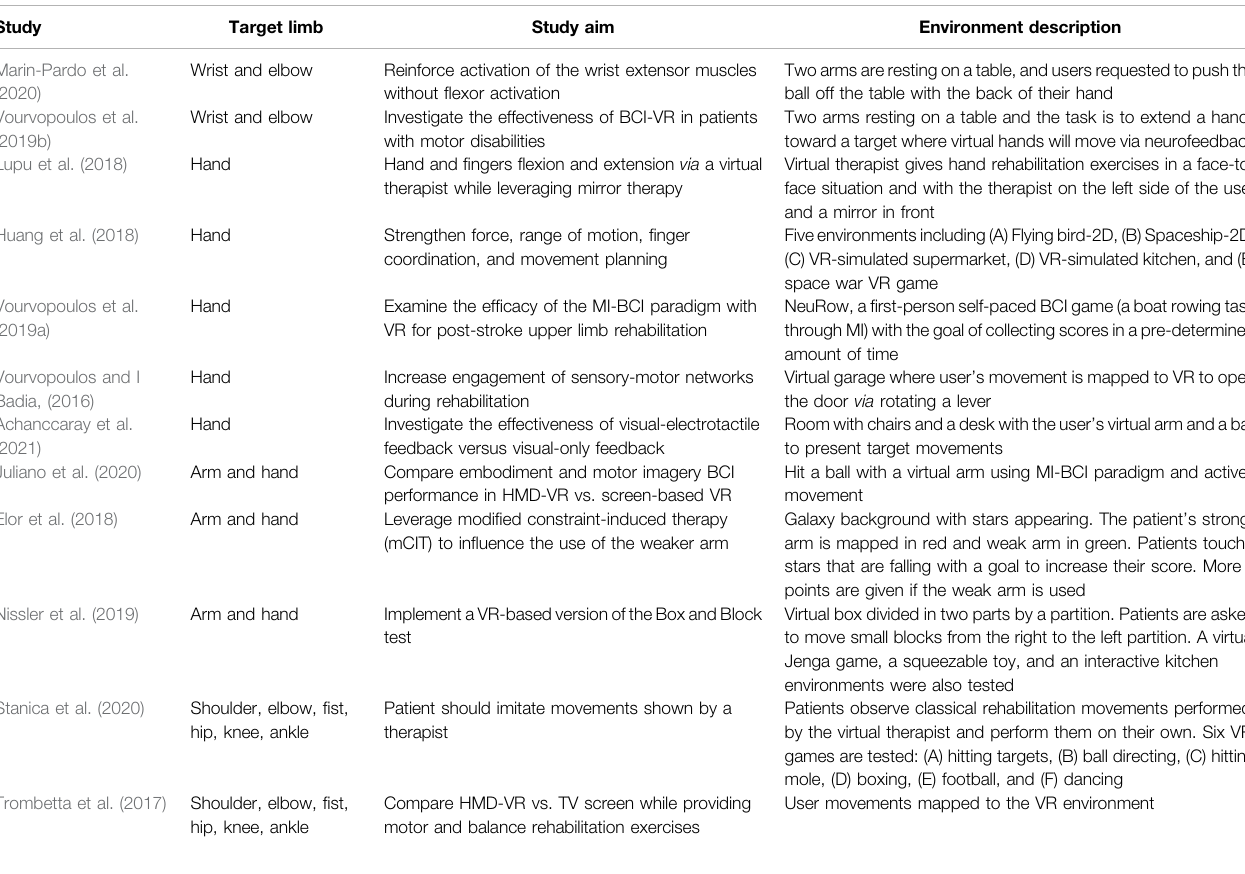
TABLE 3 | Characteristic of reviewed studies, including target limbs, study aim, and virtual environment description.